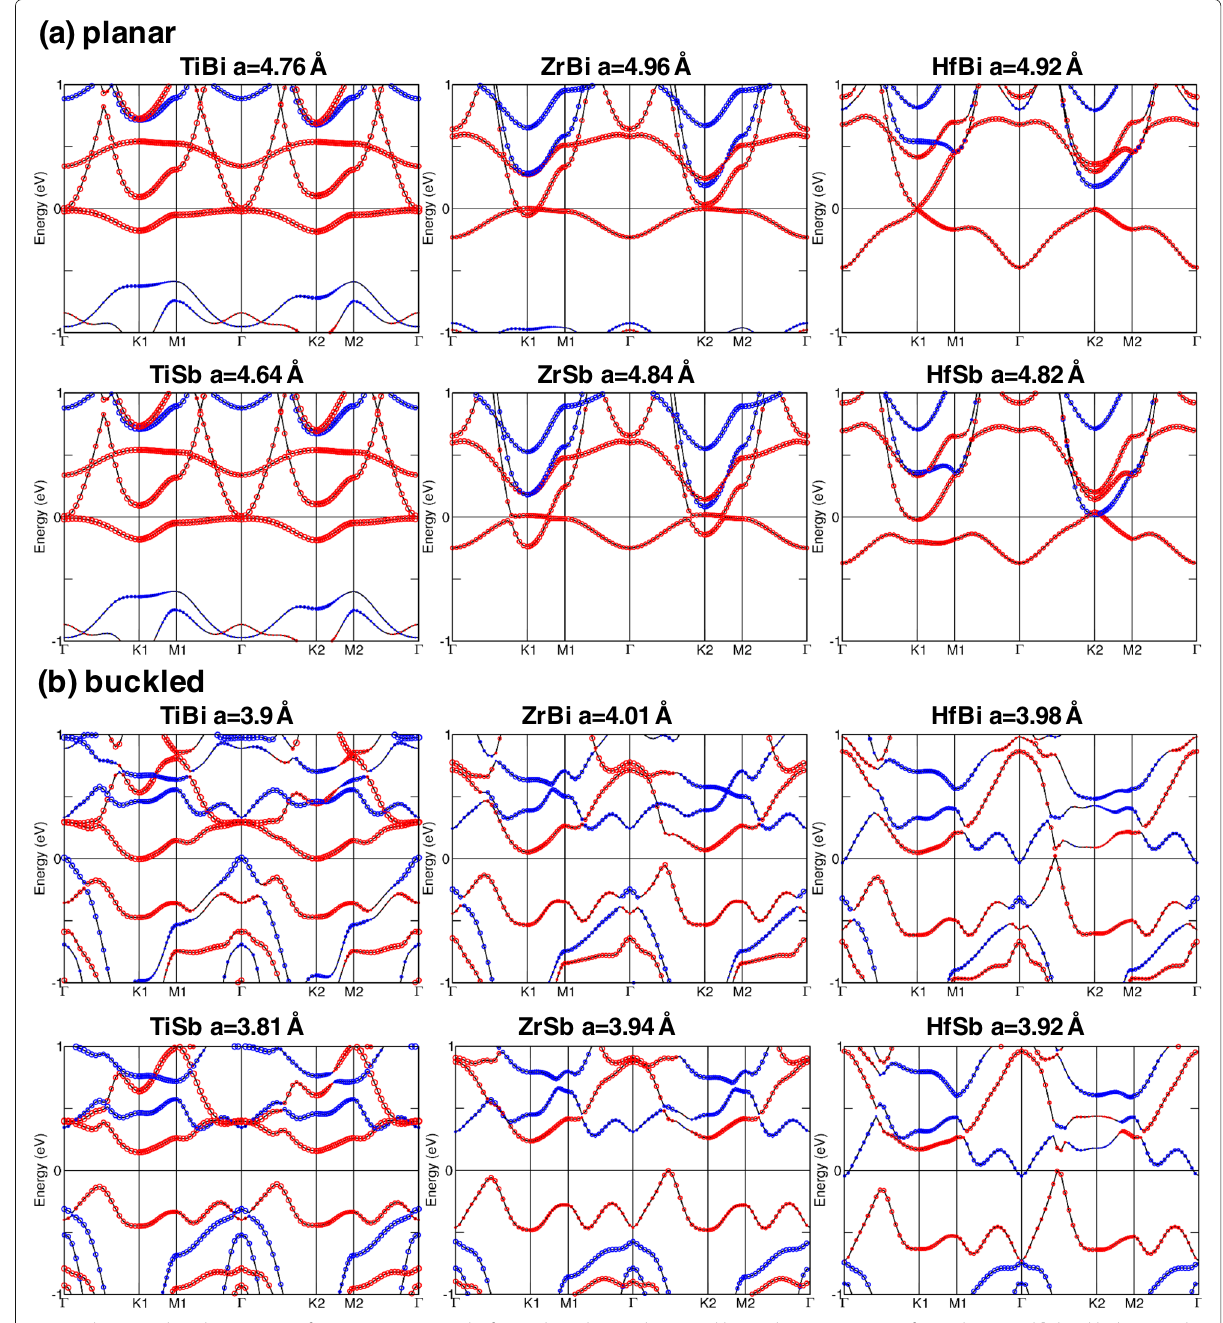
Fig. 5 Electronic band structures of M-Pn (M=Ti, Zr, and Hf; Pn=Sb and Bi) at their equilibrium lattice constants for a planar and b buckled cases. The equilibrium lattice constants are given above the band structure. Red and blue circles indicate + s z and − s z contributions, respectively